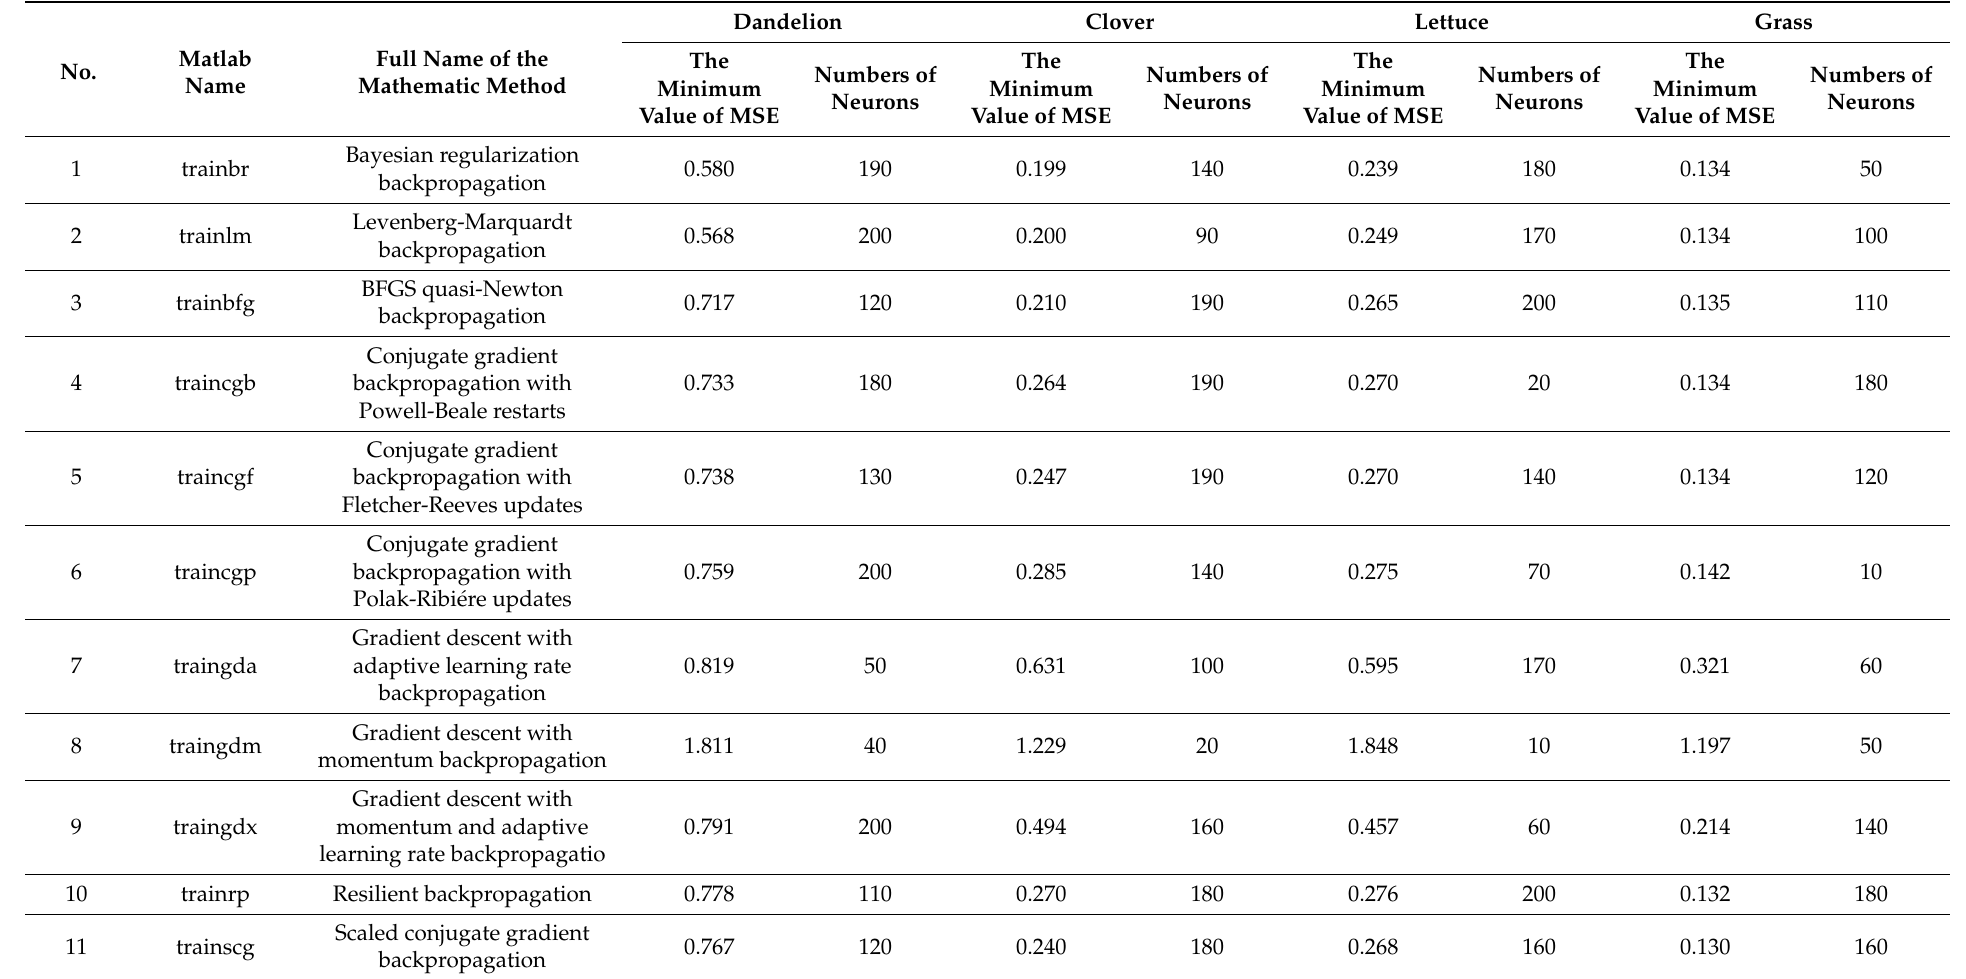
Table 2. The minimum value of MSE for the appropriate number of neurons for